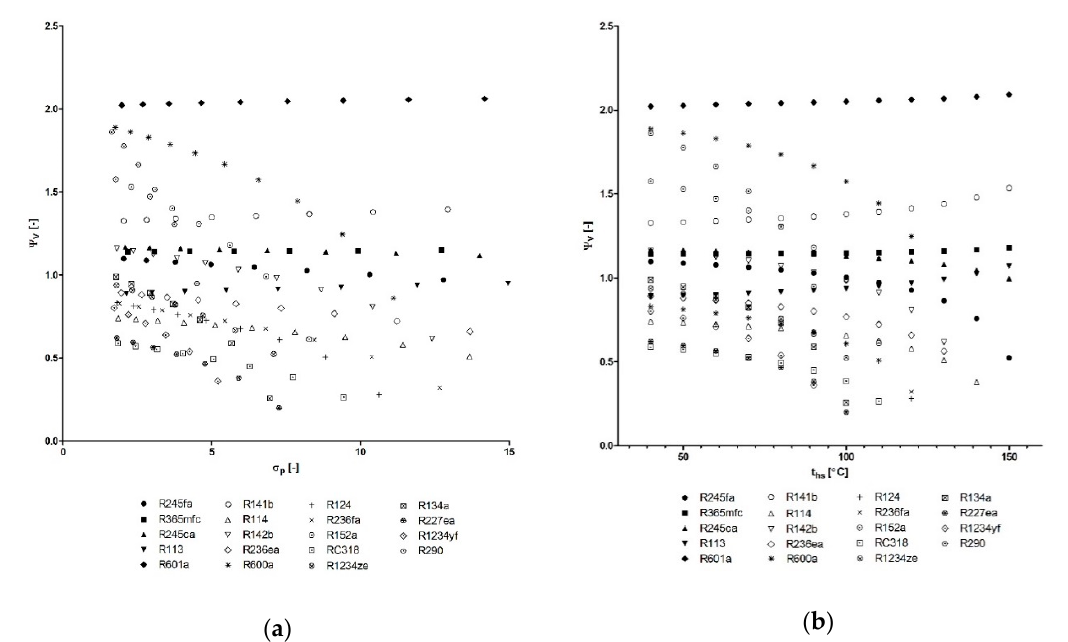
Figure 14. The variation of the ψ V parameter vs. the pressure expansion ratio and heat source temperature: ( a ) ψ V = f( σ P ); ( b ) ψ TME = f(t hs ).